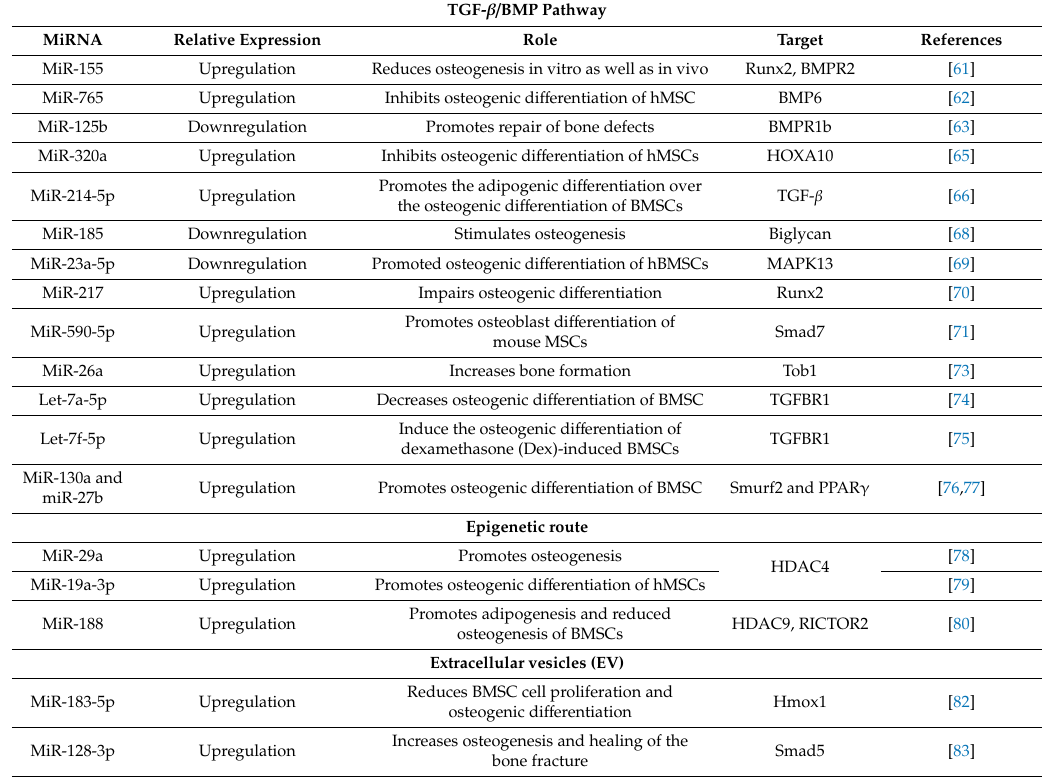
Table 3. MiRNAs involved in BMSC